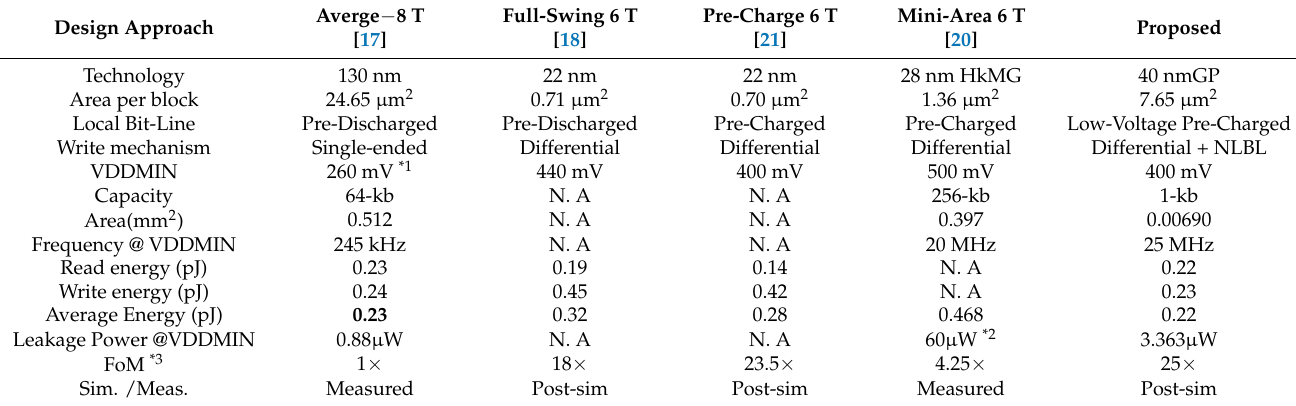
Figure 11. Post-layout simulation waveform for SRAM Chip @400 mV/25 MHz/TT corner. Table 3 shows the comparison of proposed local bit-line SRAMs architecture perfor- mance and previous work. The comprehensive summary of the proposed local bit-line SRAM has smaller average energy consumption than the MINI-Array [20] and the highest FoM performance. Table 3. Comparison of previous and proposed SRAM based on the local bit-line structure.